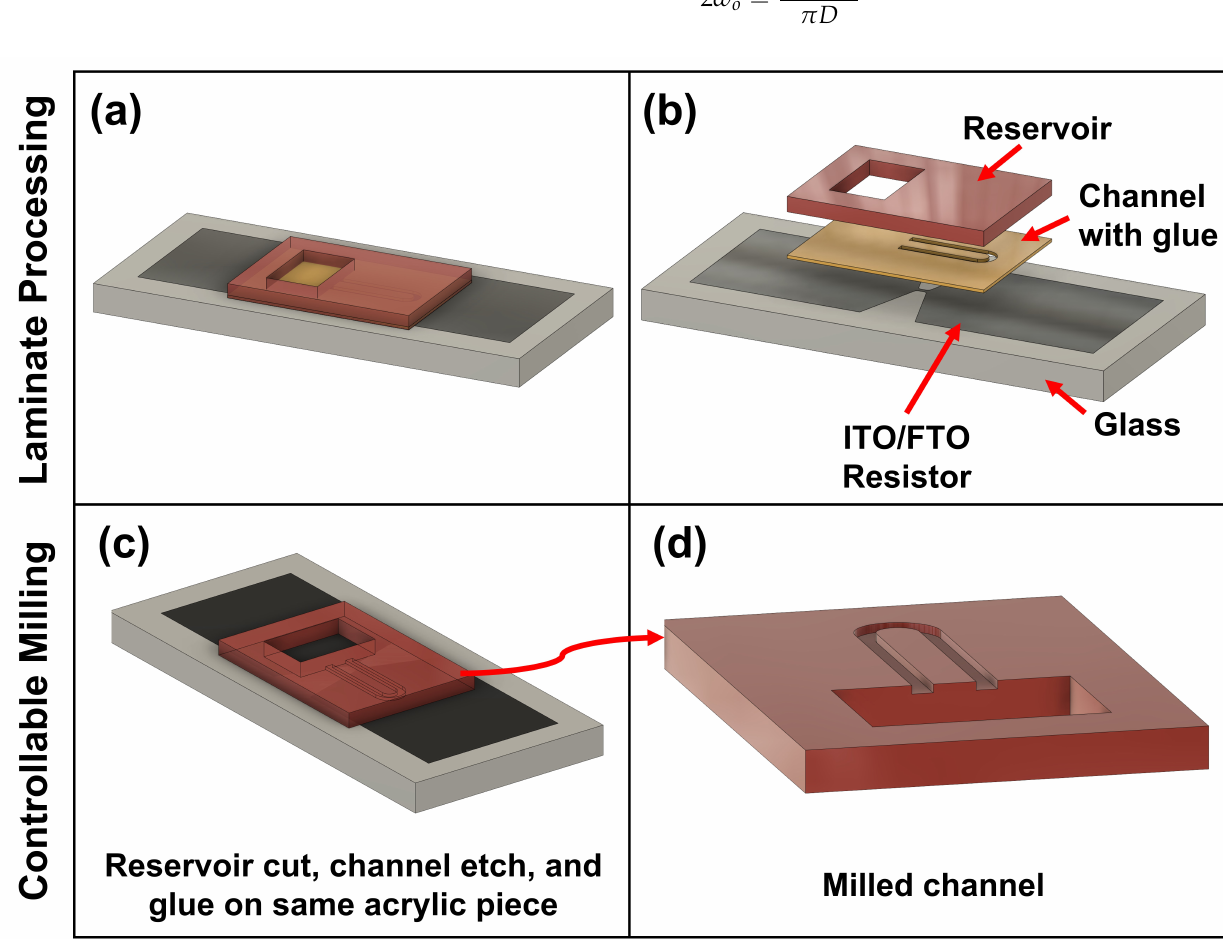
Figure 4. Microfluidic Fabrication Processes—illustrates both laminate and controllable milling microfluidic fabrication processes. ( a , b ) show laminate processing in which a 58.42 µ m glue layer is laminated to both sides of a 200 µ m thick acrylic sheet, and the channel and reservoir layers are defined through laser cutting. ( c ) shows controllable milling on the femtosecond laser cutter system to produce 2.5D microfluidic geometries. Unlike laminate processing, a single acrylic substrate is used upon which the channel and reservoir is defined. ( d ) shows a close up of the milled channel region. For the beam power, a Newport power meter (model 843-R) was used to measure the power at different laser repetition frequencies at the cutting surface. The femtosecond laser system used a pulse width of 247 fs. Figure 5b shows that the laser power can be approximated as a Sigmoid function in that it logarithmically decays with the laser repetition frequency. Material etch rates were determined by performing a cross-hatch etch with a line spacing of 3 µ m at various laser repetition frequencies and number of layers (or passes) as shown in (c). The etch rate was found to be linearly related to the repetition frequency